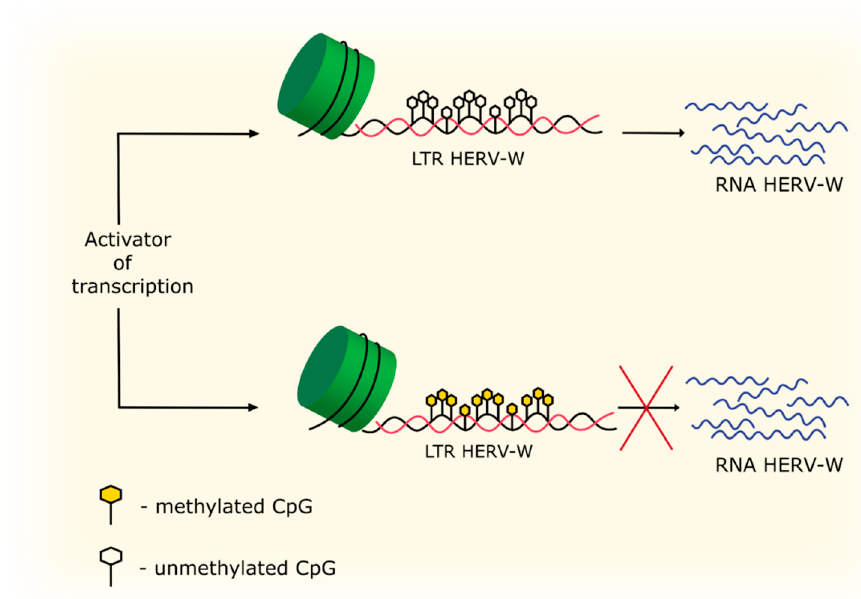
Figure 4. Regulation of HERV-W transcription by methylation of CpG sites in the promoter region.